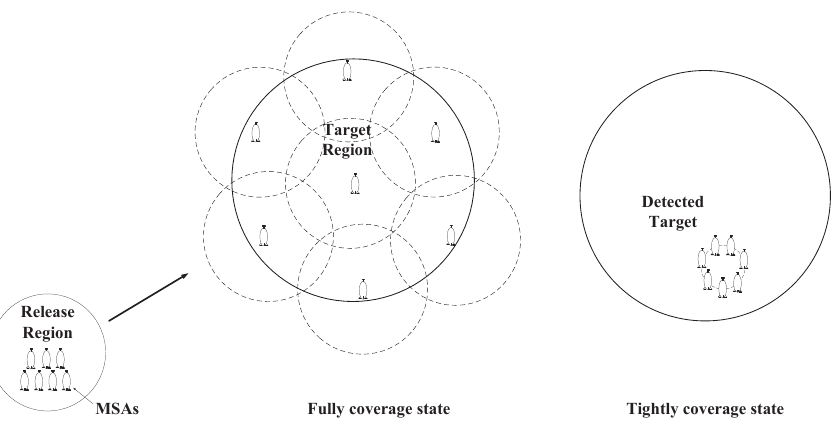
Figure 2. Depiction of the region-coverage